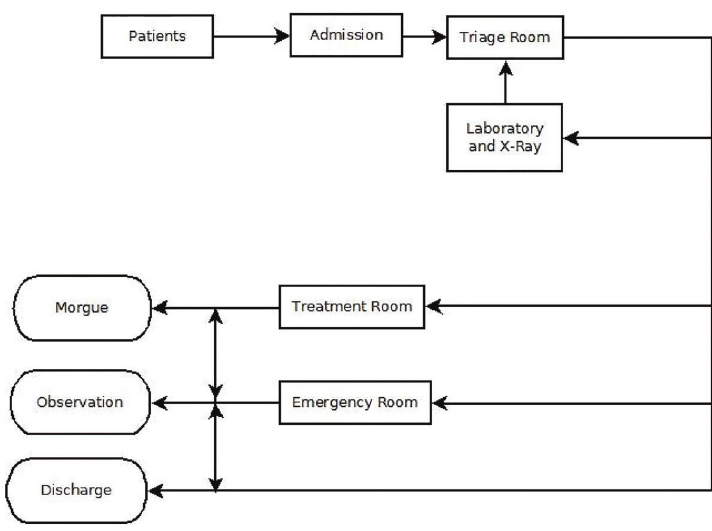
Figure 1. Simpli fi ed fl ow of patients in an emergency